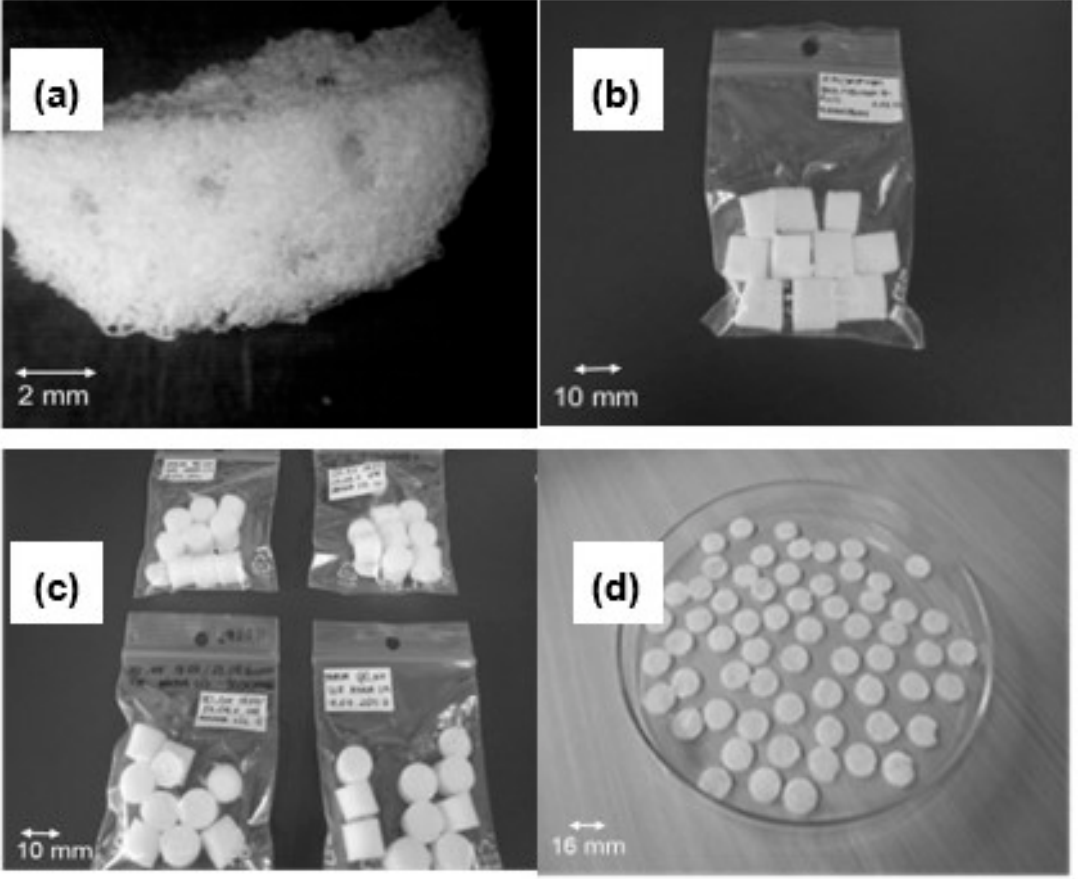
Figure 2. PU / PLDL (poly(L / D,L-lactide) sponges prepared by the solvent-casting / salt-leaching method: multichannel sponges ( a ), sponges for mechanical tests ( b , c ), samples for degradation tests ( b ), and sponges for in vitro biological tests ( d ). Scale bar 10mm.